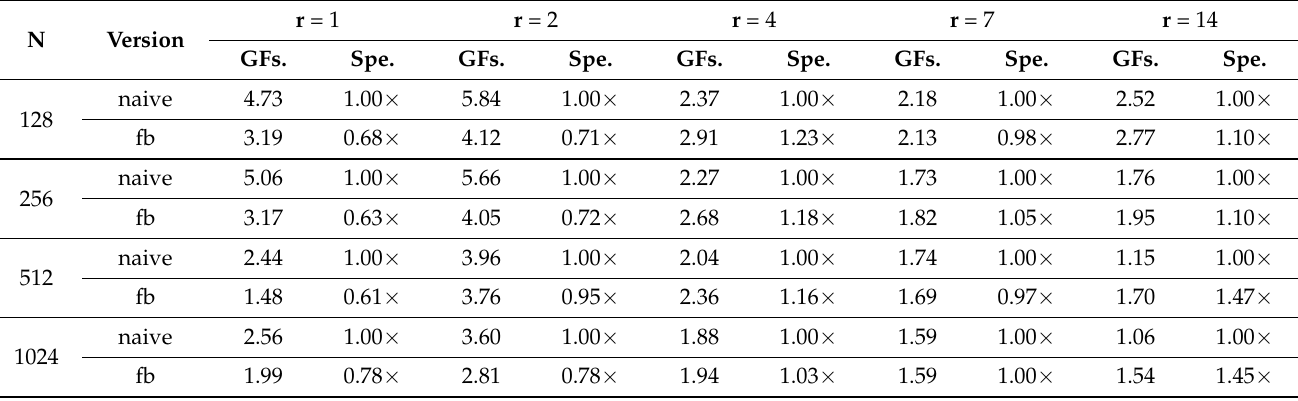
Table 6. Experimental results of the proposed transformation recipes: (h) forward and backward algorithm